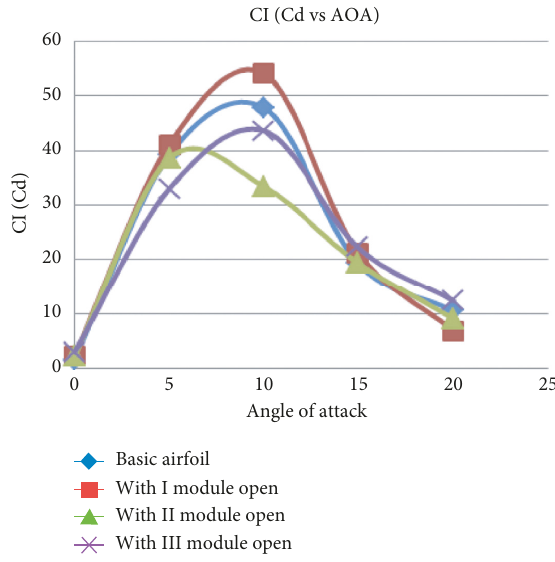
Figure 20: Plot between C l / C d and angle of attack.